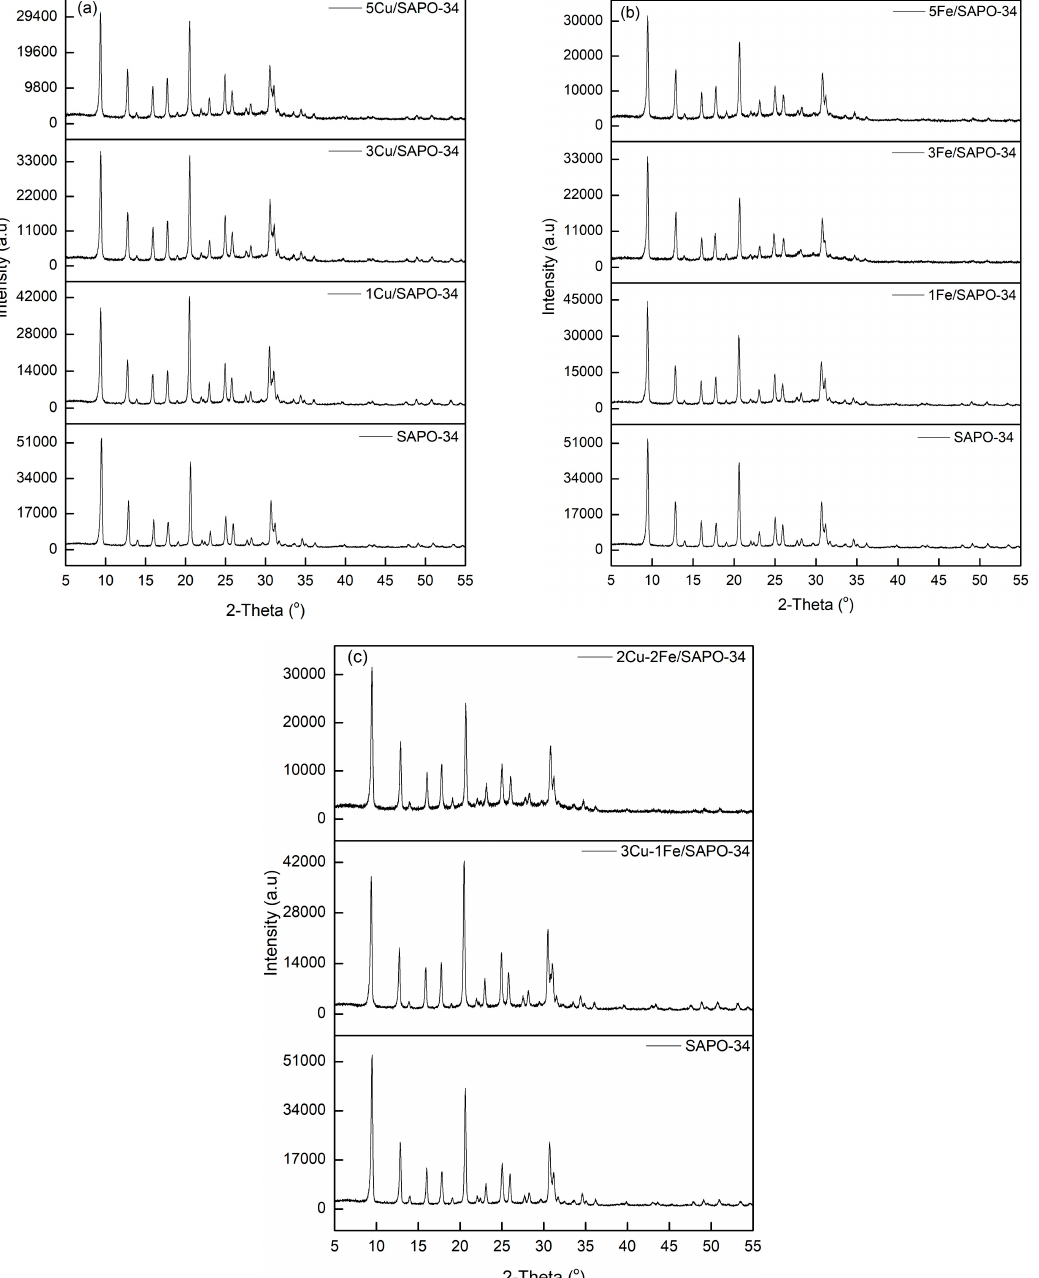
Figure 1. X-ray powder di ff raction patterns of as-synthesized SAPO-34 and catalyst ( a ) Cu / SAPO-34, Figure 1 . X-ray powder diffraction patterns of as-synthesized SAPO-34 and catalyst ( a ) Cu/SAPO-34, ( b ) Fe / SAPO-34, and ( c ) Cu-Fe / SAPO-34 with various metal ( b ) Fe/SAPO-34, and ( c ) Cu-Fe/SAPO-34 with various metal content.